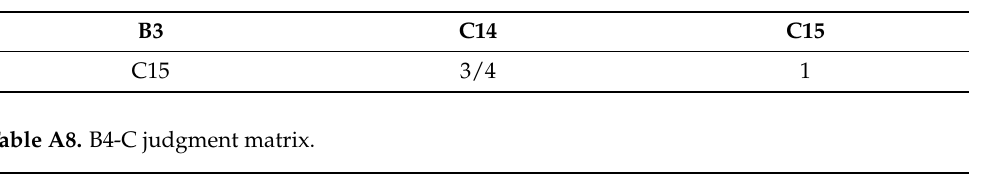
Table A7. B3-C judgment matrix.